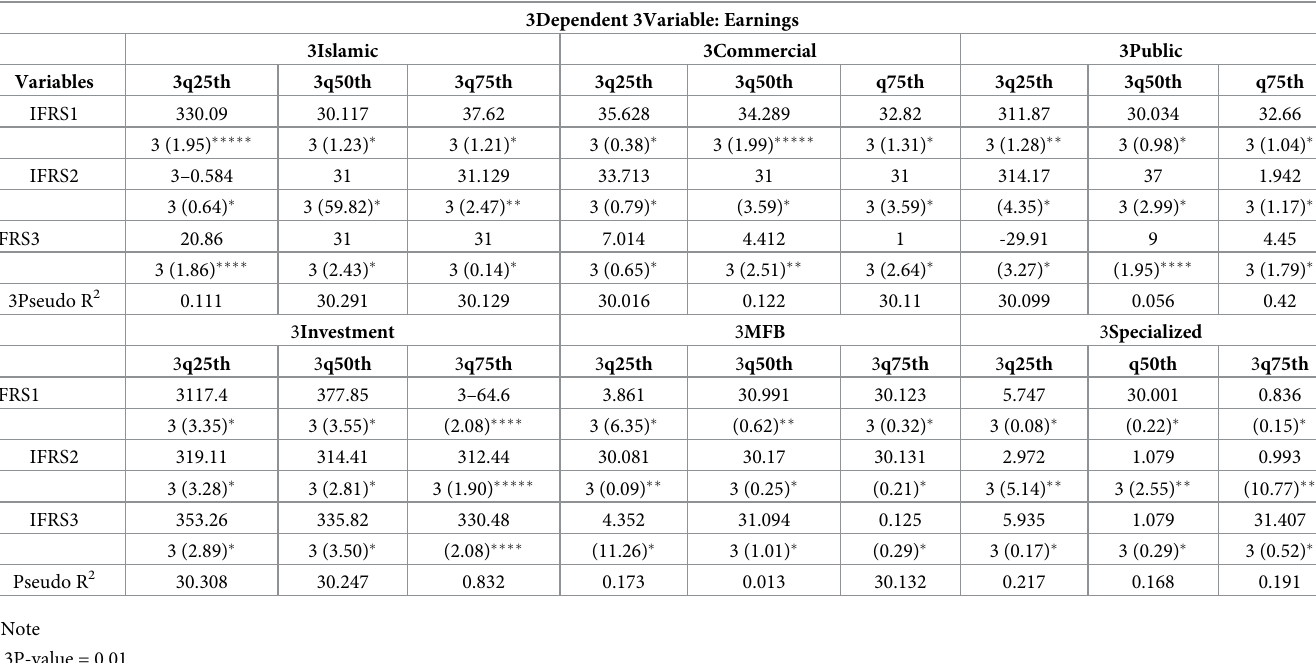
Table 4. Quintile regression